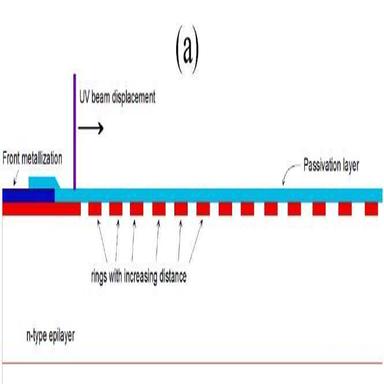
a) Schematic showing the half-vertical PiN diodes shielded by 22 field rings. b) picture of the diode with the gold ball bonding of 50 μm in diameter.